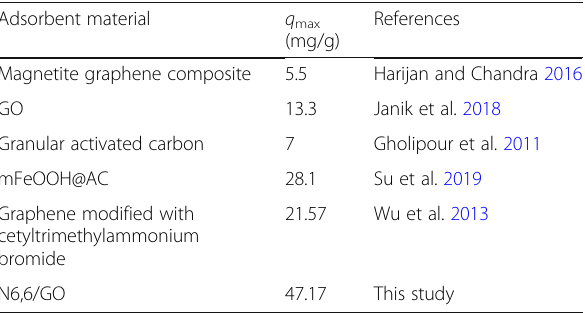
Table 2 Comparison of the adsorption capacities of Cr (VI) ions onto the various adsorbent Adsorbent material q max